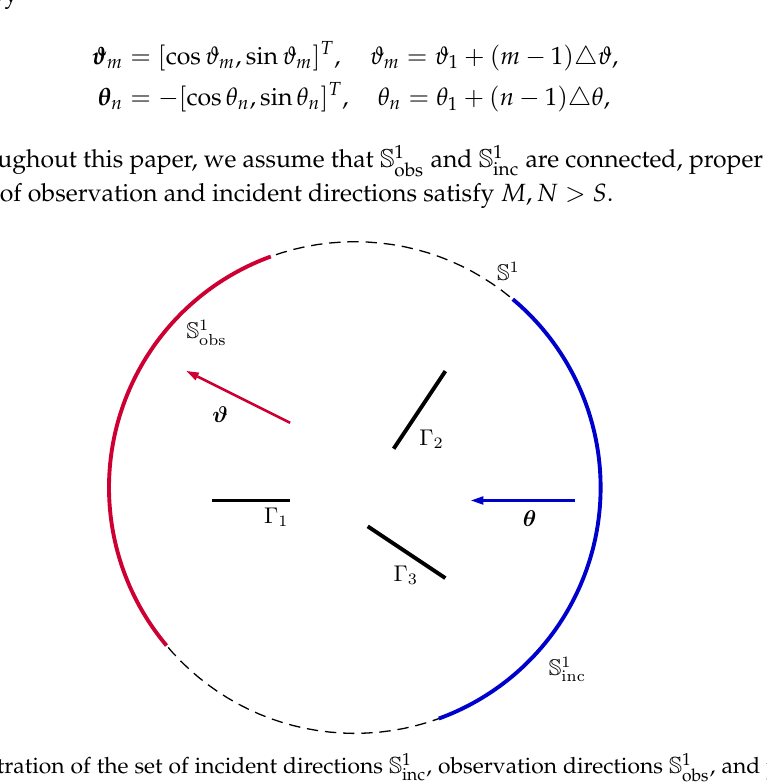
, observation directions S 1 inc